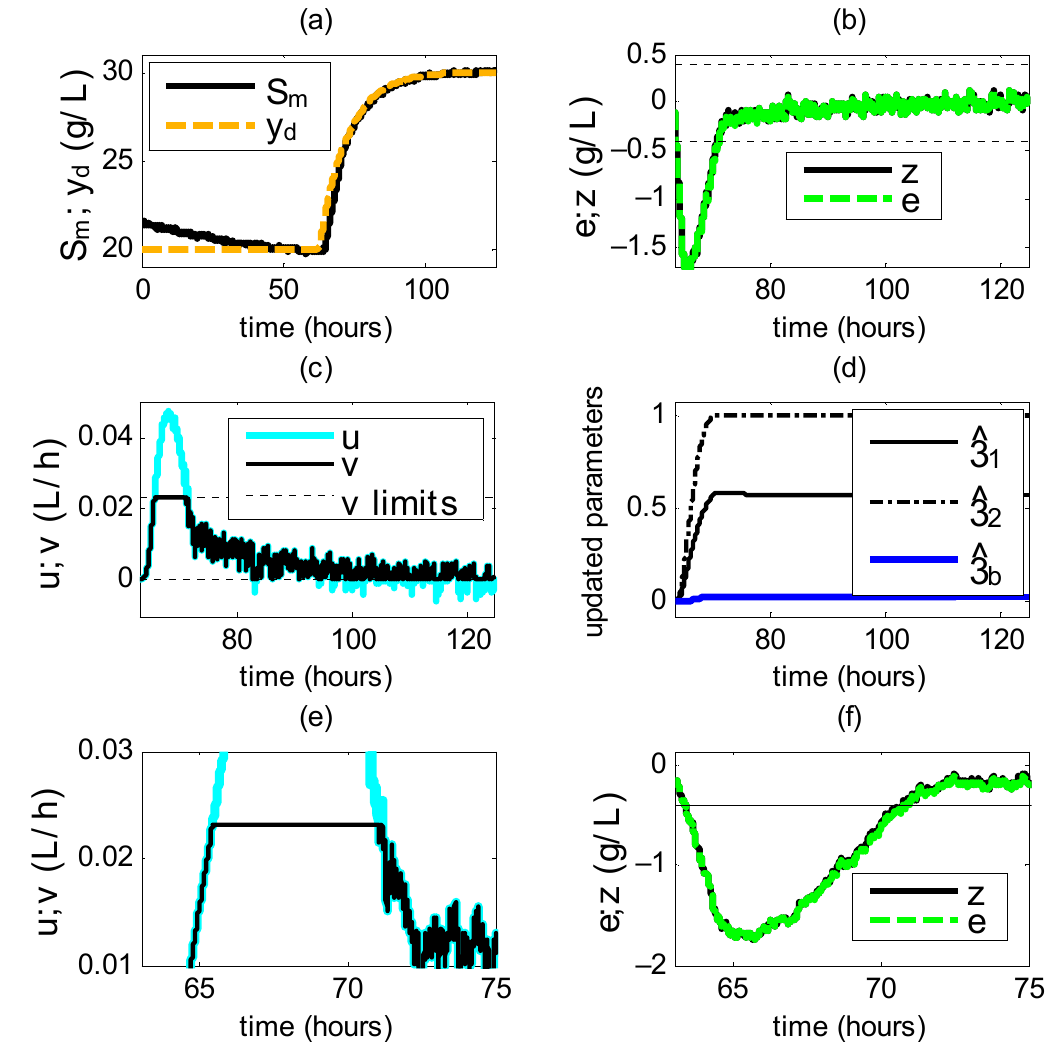
Figure 1. Simulation results for the first case of reference model and controller parameter values. ( a ) Time course of the measured output S m and the desired output y d . ( b ) Time course of the tracking error e and the modified error z . ( c ) Time course of the non-saturated input u and the saturated input υ . ( d ) Time course of the updated parameters ˆ θ 1 , ˆ θ 2 , ˆ θ b . ( e ) Detail of non-saturated input u and the saturated input υ . ( f ) Detail of the tracking error e and the modified error z .